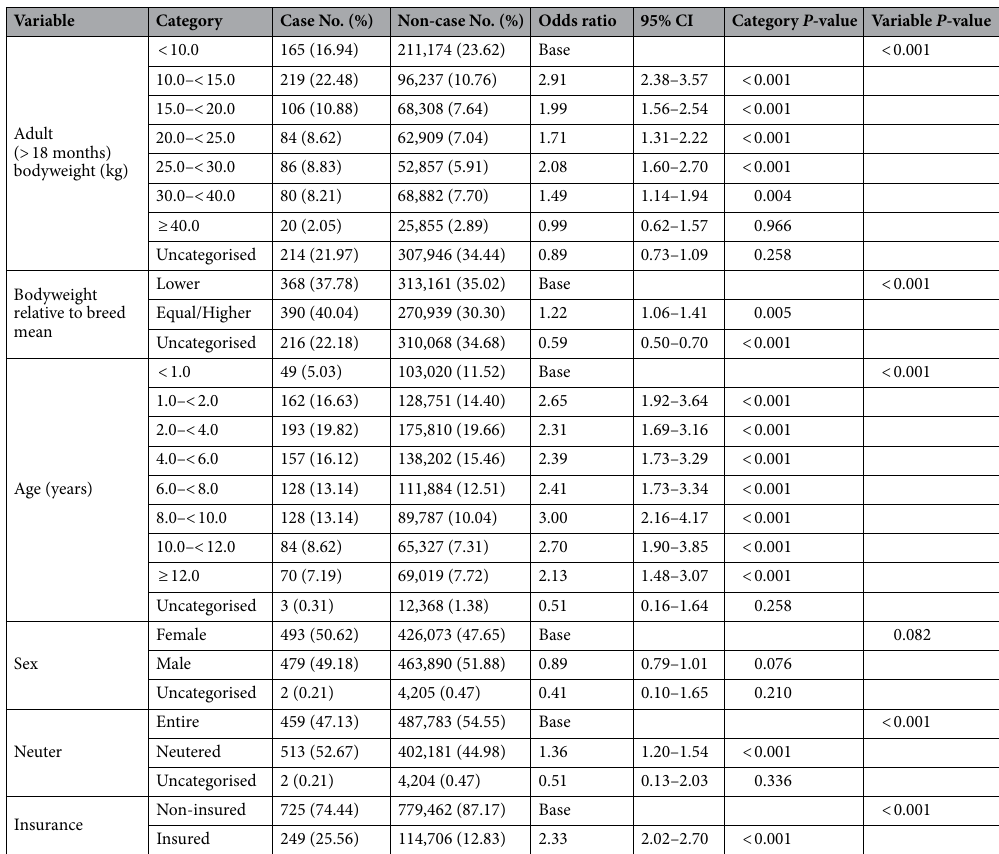
Table 4. Descriptive and univariable logistic regression results for non-breed-related demographic risk factors evaluated for skin fold dermatitis during 2016 in dogs under primary veterinary care in the VetCompass Programme in the UK. Column percentages shown in brackets. CI confidence